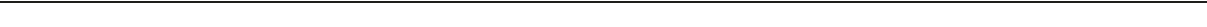
Fig. 3 Safety evaluation of PQ-loaded vesicles in cell model. a Cytotoxicity evaluation of PQ and PQ-loaded vesicles incubated in L-02 cells and COS-7 cells before and after exposure to UV light. Error bar corresponds to the SD ( n = 3). * P ≤ 0.05, ** P ≤ 0.01, and *** P ≤ 0.001 determined by two-way ANOVA followed by Dunnett ’ s test. b Intracellular ROS in L-02 cells and COS-7 cells. Apoptosis rates (measured by fl ow cytometry) and quantitative analysis on the apoptosis rates of c , d L-02 cells, and e , f COS-7 cells, induced by PQ and PQ-loaded vesicles under different conditions of light exposure. The error bar corresponds to the SD ( n = 3). * P ≤ 0.05, ** P ≤ 0.01, and *** P ≤ 0.001 determined by one-way ANOVA followed by Dunnett ’ s test. g Intracellular payload release of NR-loaded vesicles in L-02 cells and COS-7 cells before (control group) and after exposure to UV light for 16 s after co-incubation for 10, 20, and 30 min. Scale bar: 100 μ